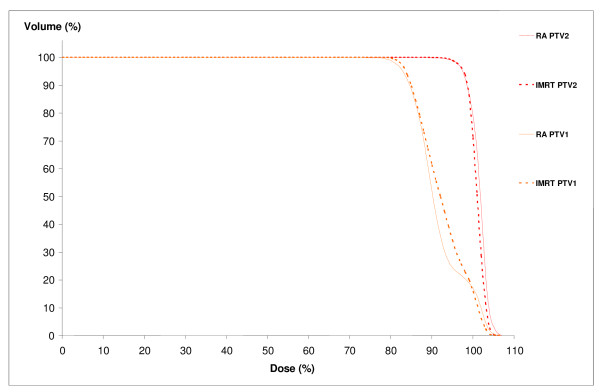
Dose-volume histograms for PTV. RA, Rapidarc; IMRT, intensity-modulated radiotherapy